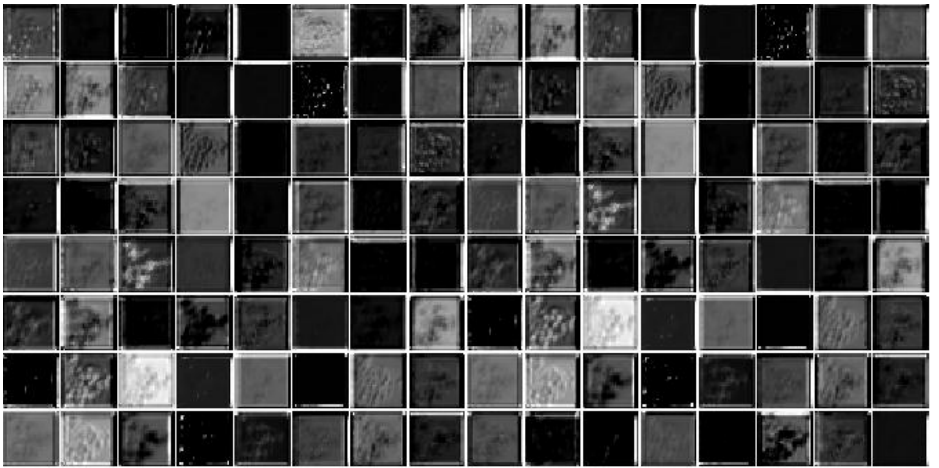
Figure 3. The first 128 channels of deep